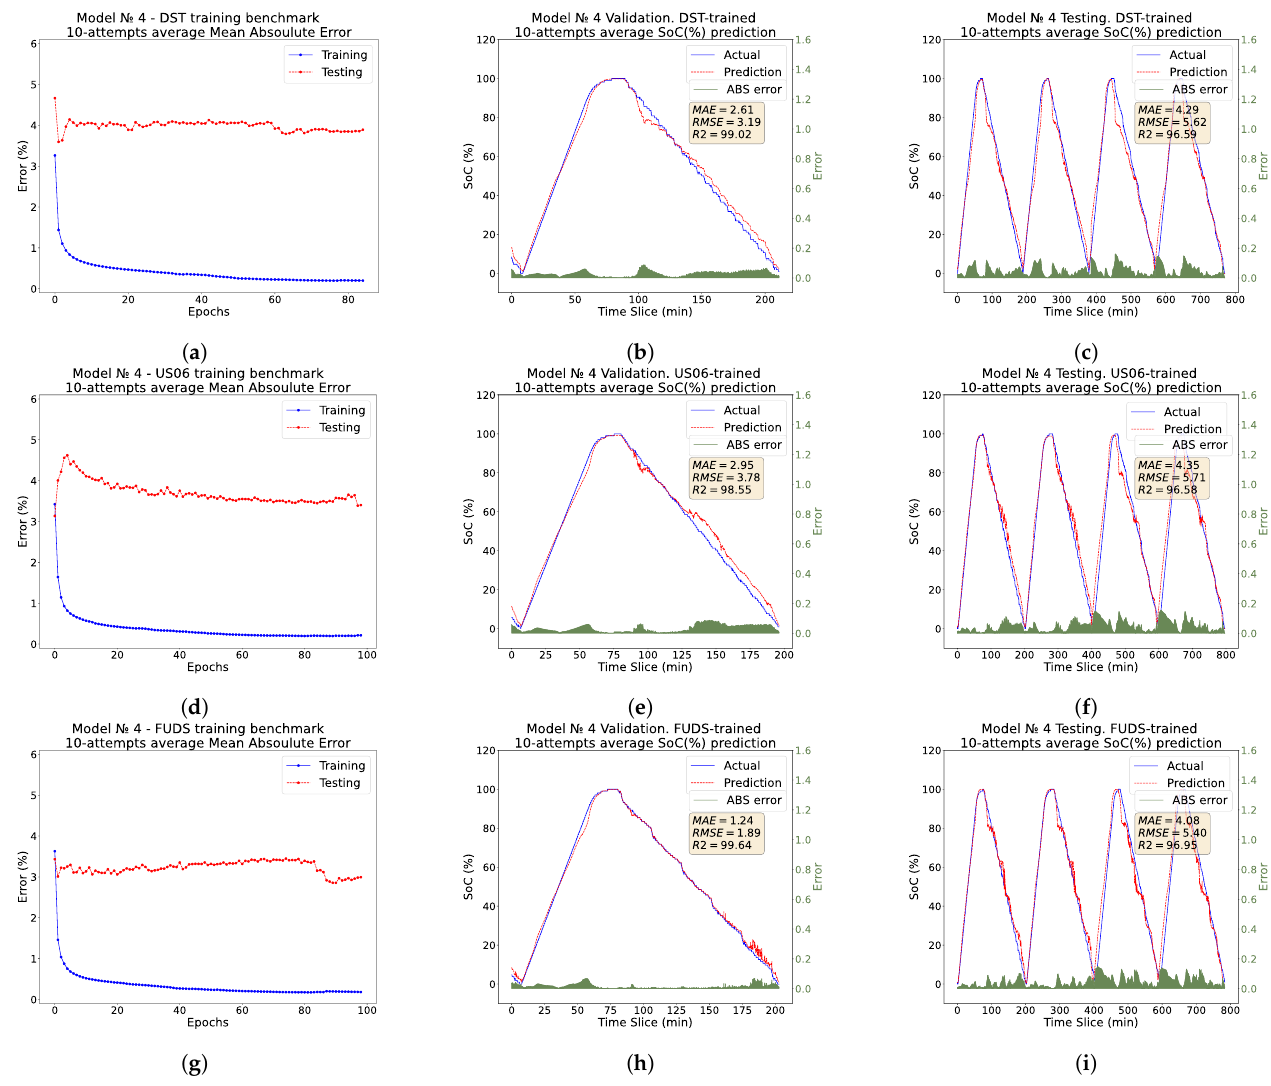
Figure 17. Model 4: Stateless GRU with Robust optimiser. ( a ) Average training and testing MAE history; average of 10 attempts. ( b ) Validation on a single cycle of SoC estimation; average of 10 attempts at 25 °C. ( c ) Testing on two cycles of US06 and FUDS profiles; average of 10 attempts. ( d ) Average training and testing MAE history; average of 10 attempts. ( e ) Validation on a single cycle of SoC estimation; average of 10 attempts at 25 °C. ( f ) Testing on two cycles of DST and FUDS profiles; average of 10 attempts. ( g ) Average training and testing MAE history; average of 10 attempts. ( h ) Validation on a single cycle of SoC estimation; average of 10 attempts at 25 °C. ( i ) Testing on two cycles of DST and US06 profiles; average of 10